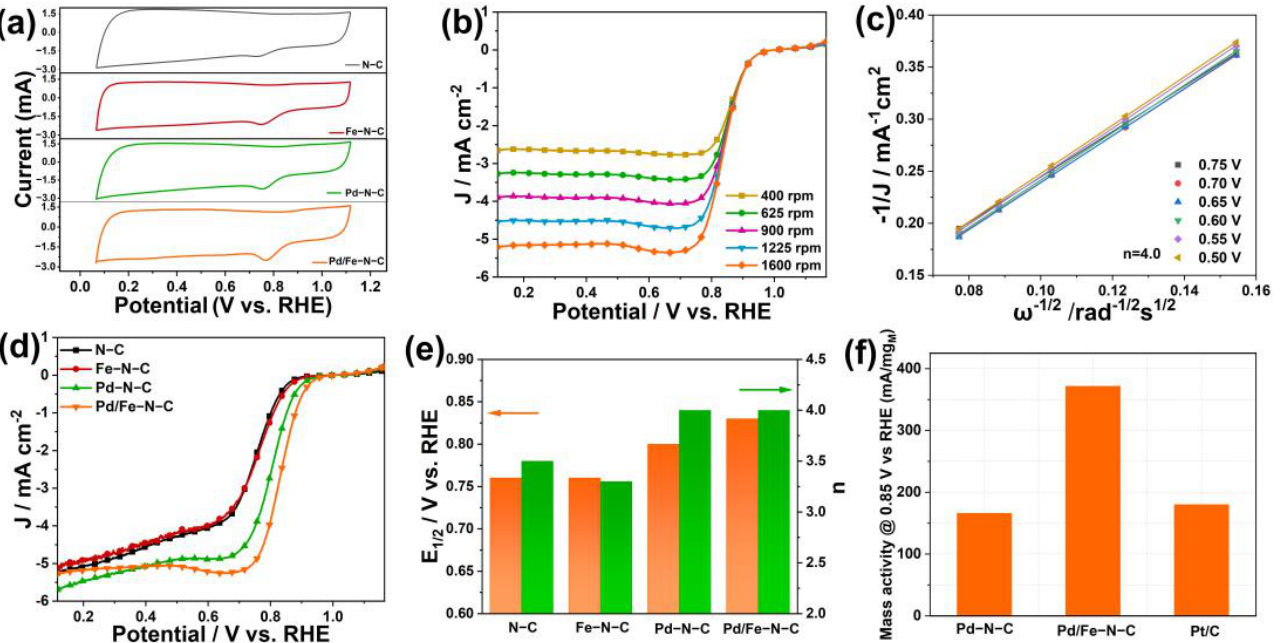
Figure 3. ( a ) CV curves of the four catalysts in an O 2 -saturated 0.1 M KOH solution. ( b ) LSV curves of Pd/Fe−N−C in an O 2 -saturated 0.1 M KOH solution at different rotation rates. ( c ) Koutecky – Levich plots of Pd/Fe−N−C at different potentials. ( d ) Comparison of the polarization curves of the four catalysts at 1600 rpm. ( e ) Comparison of the half-wave potential (E 1/2 ) and electron transfer number (n) of the four catalysts. ( f ) Comparison of the mass activity of the catalysts (M stands for Pd or Pt).